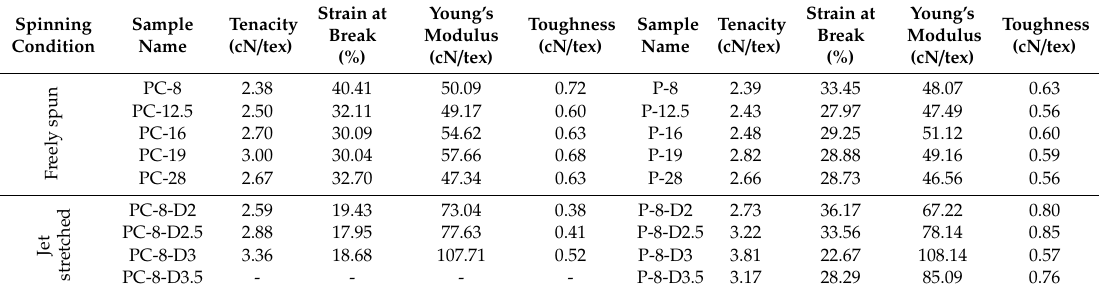
Table 4. Mechanical properties of PAN and PAN / CNT fibers at di ff erent shear rates and jet stretch